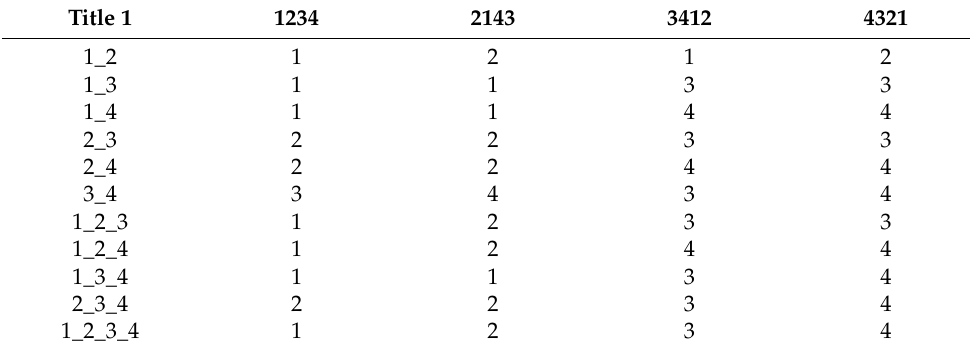
Table 1. Table of conflict resolutions in Semaphore module.